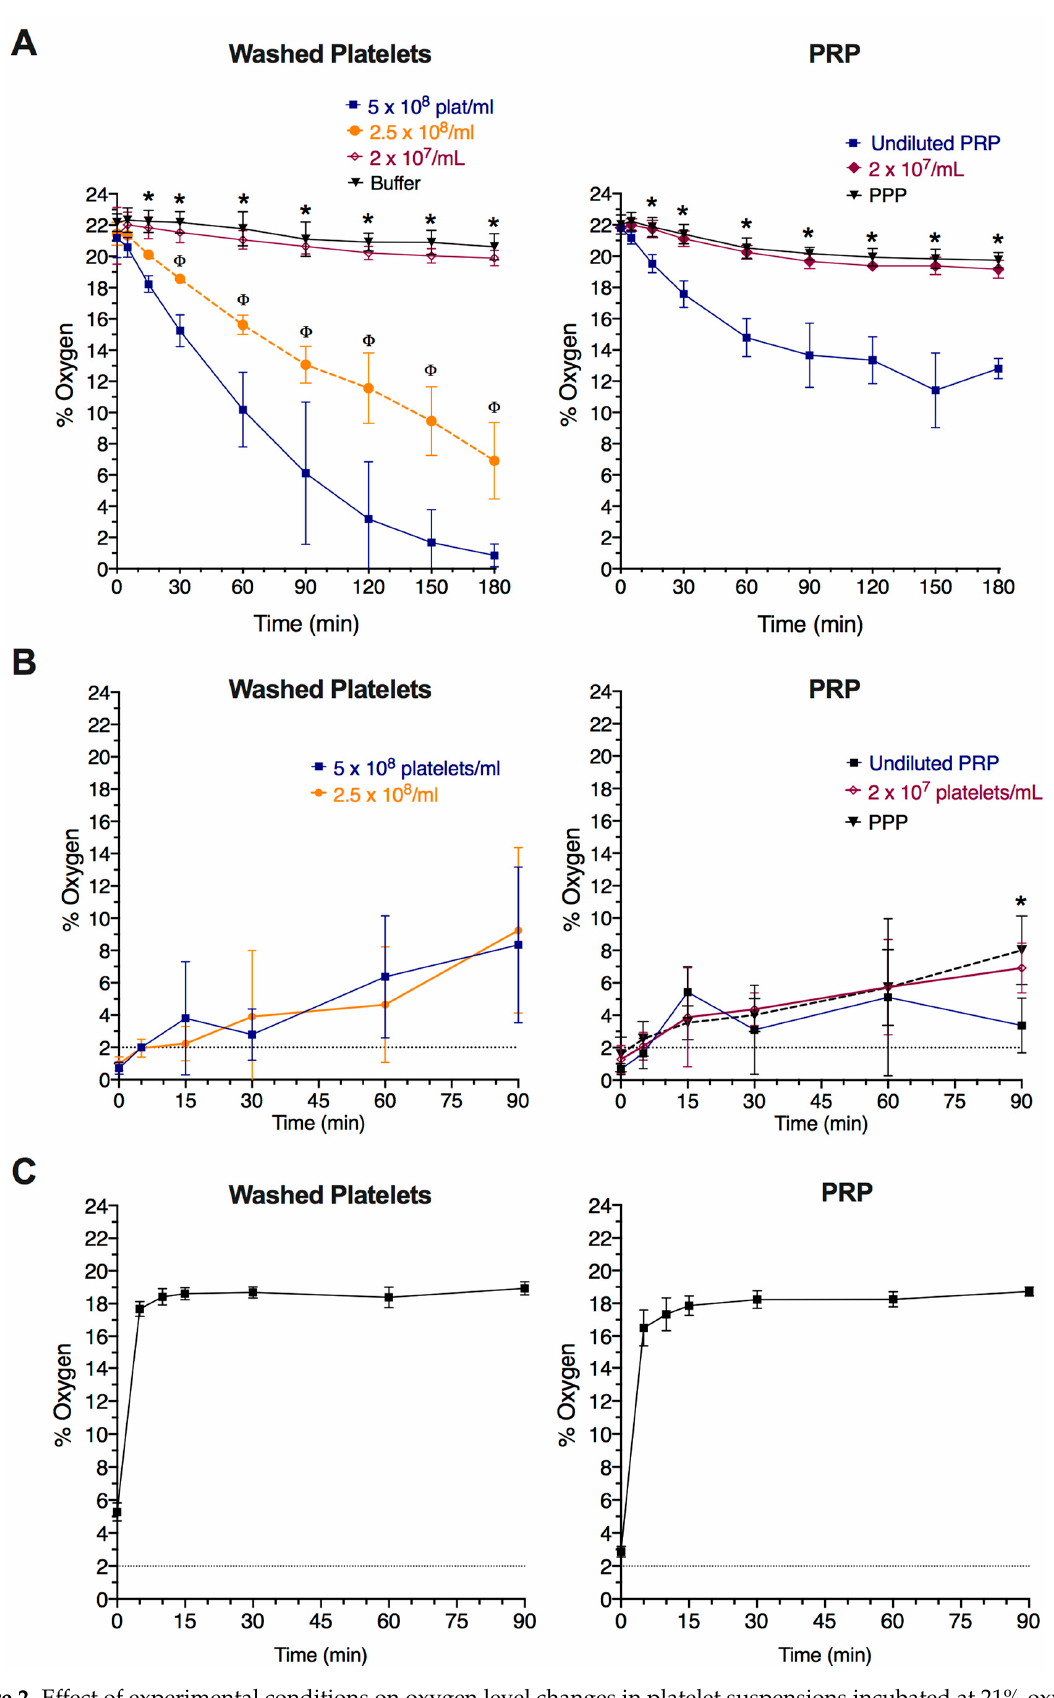
Figure 2. Effect of experimental conditions on oxygen level changes in platelet suspensions incubated at 21% oxygen. Dissolved oxygen levels were measured using a fibre optic oxygen sensor in different samples as follows: ( A ) Platelet